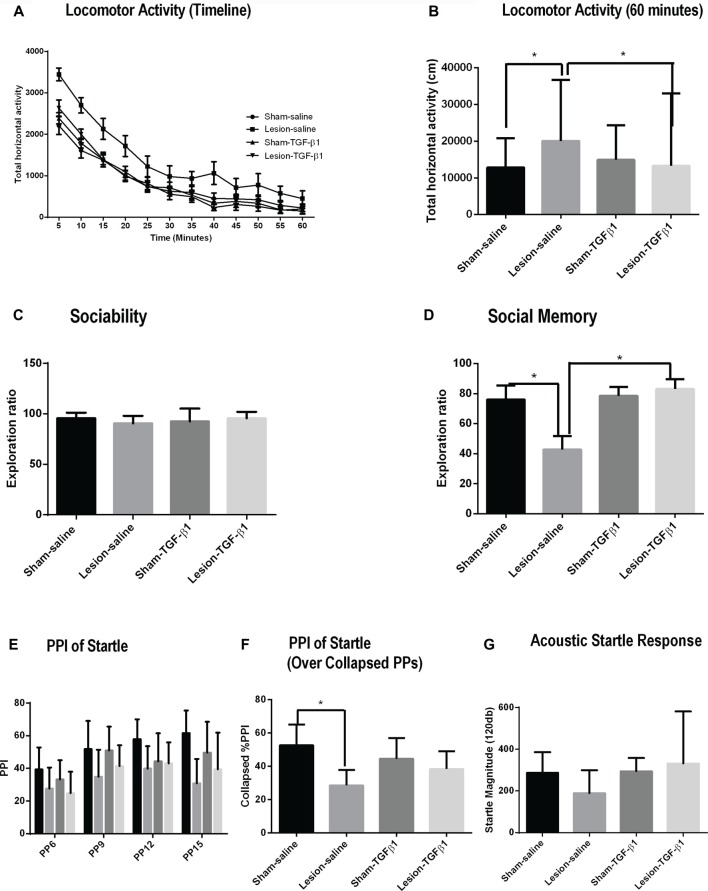
Effect of neonatal TGF-β1 administration on sham and NVHL animals at PD60. (A,B) Spontaneous locomotor activity. (A) Time course of locomotor activity as assessed by the horizontal activity in 5 min bin. (B) Total horizontal activity during the whole 60-min session. Two-way ANOVA showed a significant lesion × TGF-β1 treatment interactions on the horizontal activity (*p = 0.018). (C,D) Sociability and social memory (C) Indicates similar preferences between sham and NVHL animals for S1 animals. (D) In social memory test, significant lesion × TGF-β1 interactions was observed (*p = 0.017). (E–G) Prepulse inhibition (PPI) of acoustic startle response (ASR). (E) PPI, as a function of prepulse intensities (PP;6–15). (F) PPI collapsed across all PPs. A significant 2-way (lesion × TGF-β1) interactions was observed (*p = 0.026). (G) Baseline ASR was not significantly different between groups (n = 7–18 per group).